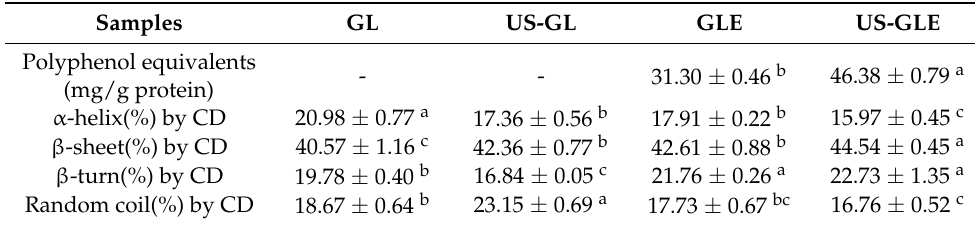
Table 1. Content of each component in samples. Samples GL US-GL GLE US-GLE Polyphenol